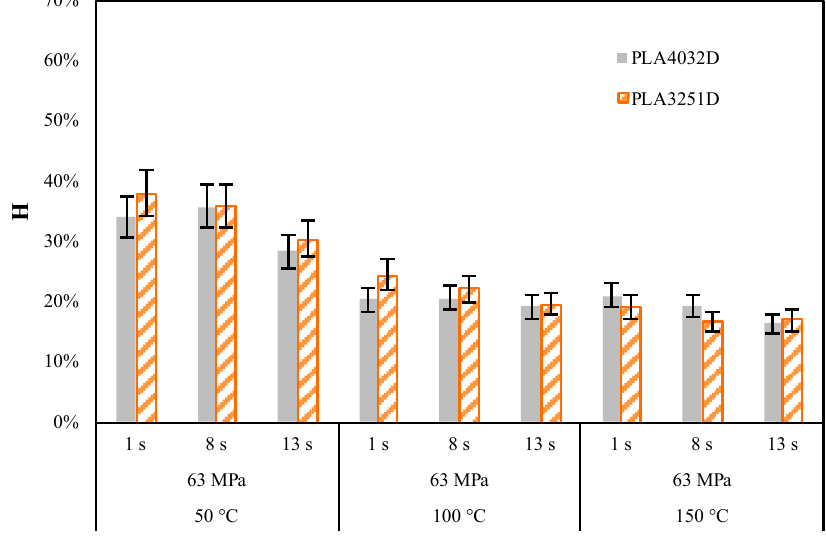
Figure 11. Comparison between the H index of nanofeatures on PLA3251D and H index of nanofeatures on PLA4032D samples obtained as indicated in Table 1.